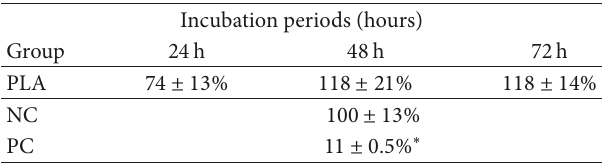
Table 1: Mean values and standard deviation of cell viability percentage for periods of 24, 48, and 72 hours ( ∗ 𝑝 < 0.0001 ; NC: negative control; PC: positive